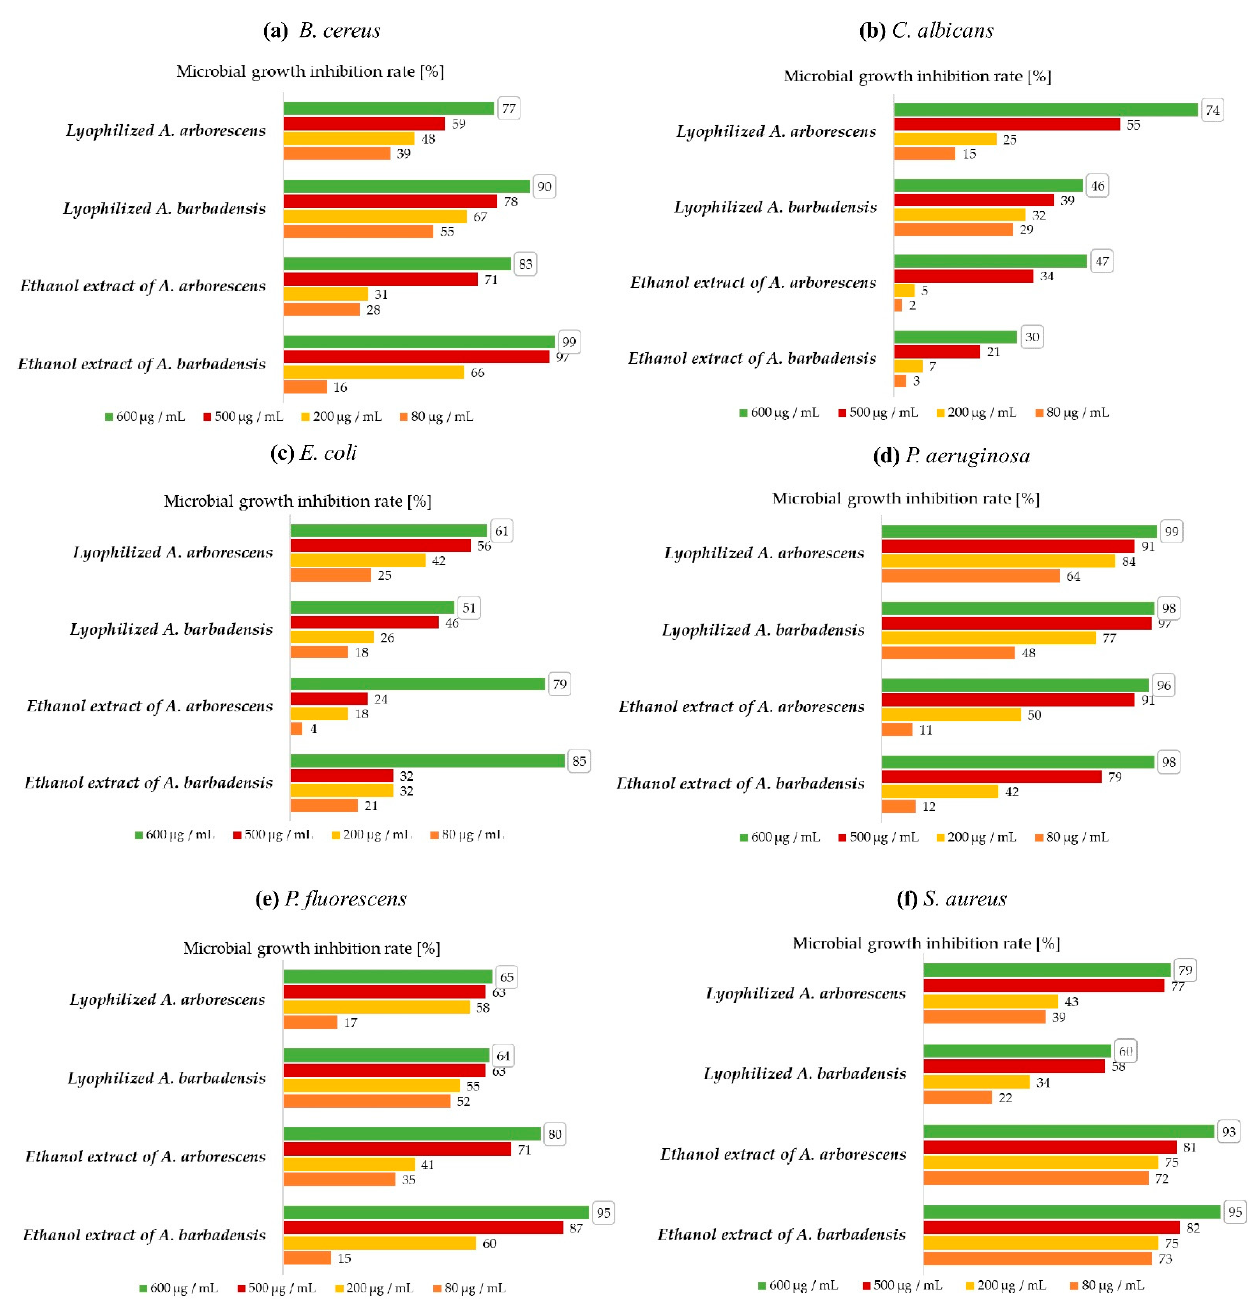
Figure 2. MGIRs for lyophilized aloe and their ethanol extracts using 600, 500, 200, and 80 µ g of sample/mL of suspension; ( a ) MGIRs for B. cereus ; ( b ) MGIRs for C. albicans ; ( c ) MGIRs for E. coli ; ( d ) MGIRs for P. aeruginosa ; ( e ) MGIRs for P. fluorescens ; ( f ) MGIRs for S. aureus ; Initial concentrations of microbial cultures: B. cereus 10 7 CFU/mL, C. albicans 10 6 CFU/mL, E. coli 10 7 CFU/mL, P. aeruginosa 10 7 CFU/mL, P. fluorescens 10 7 CFU/mL, and S. aureus 10 5 CFU/mL. The numbers in boxes indicate the highest MGIR for specific sample. Data expressed as mean ± standard deviation of three replicates that vary for max. 3%.